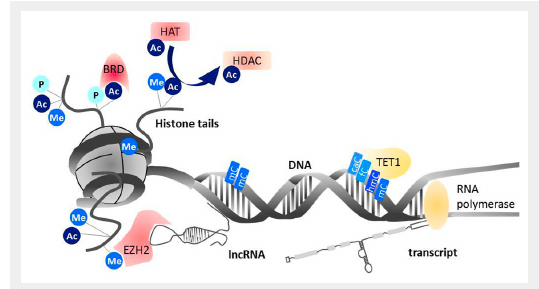
Acetyl (Ac), phospho (P) and methyl (Me) residues are placed on specific amino acids of the protruding histone tails by writer proteins. Histone acetyl transferases (HATs) and histone deacteylases (HDACs) are the readers and writers of acetylation, respectively. Bromodomains (BRDs) bind acetylated histone tails and promote the formation of multiprotein complexes. The methyltransferase EZH2 is bound to long non-coding RNA (lncRNA), which confers sequence specific location. On the DNA, ten-eleven translocation (TET) proteins convert methylated cytosines (mC) to carboxylcytosine (caC), formylcytosine (fC), and hydroxylmethylcytosine (hmC). Modified from [48] Kyburz D, et al. Epigenetic changes: the missing link. Best Pract Res Clin. 2014;28(4):577–87, with permission from